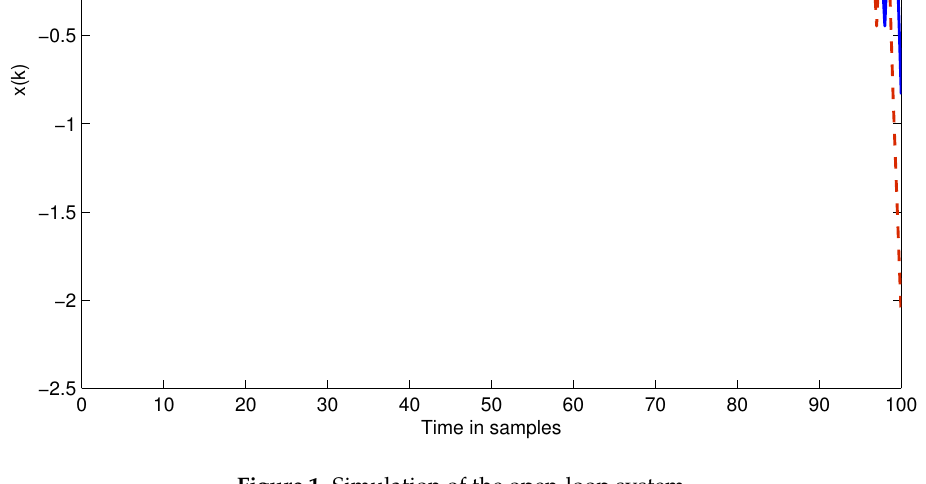
Figure 1. Simulation of the open-loop system.